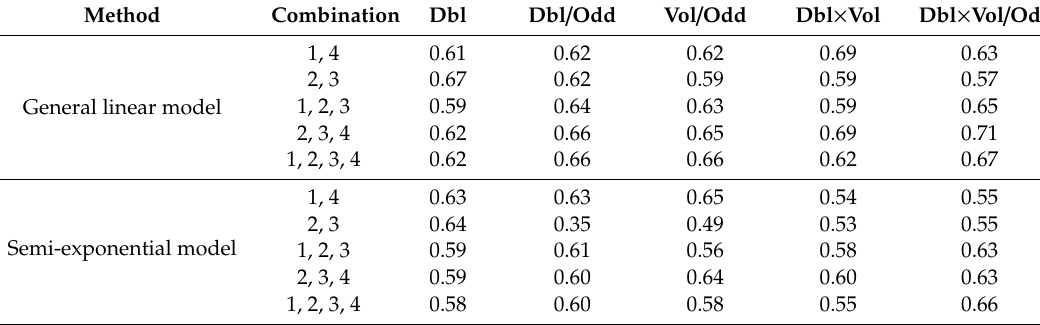
Table 6. The coe ffi cients of determination (R 2 ) between the measured GSV and the estimated plots GSV using GLM and the semi-exponential model using five un-fused and fused polarimetric characteristics from time series SAR images.